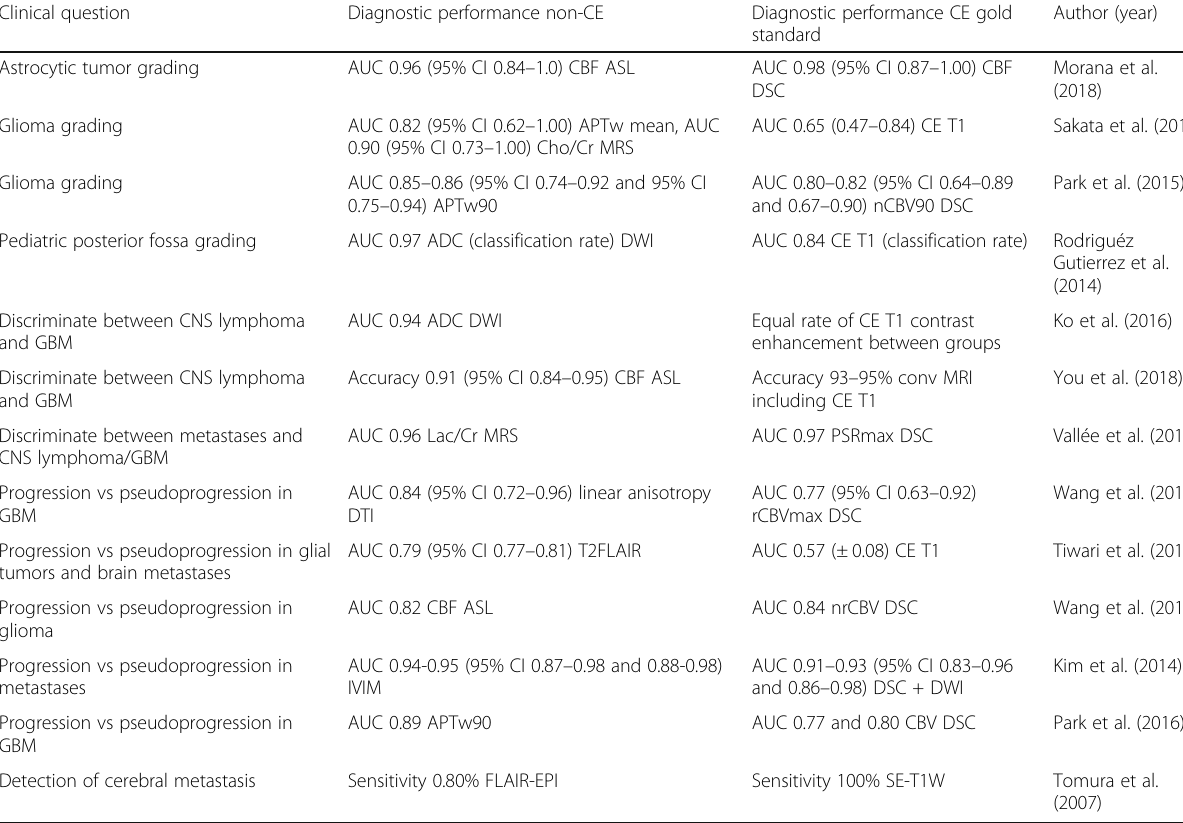
Table 3 Diagnostic accuracy measures in non-contrast-enhanced MRI techniques and contrast-enhanced techniques in brain tumor